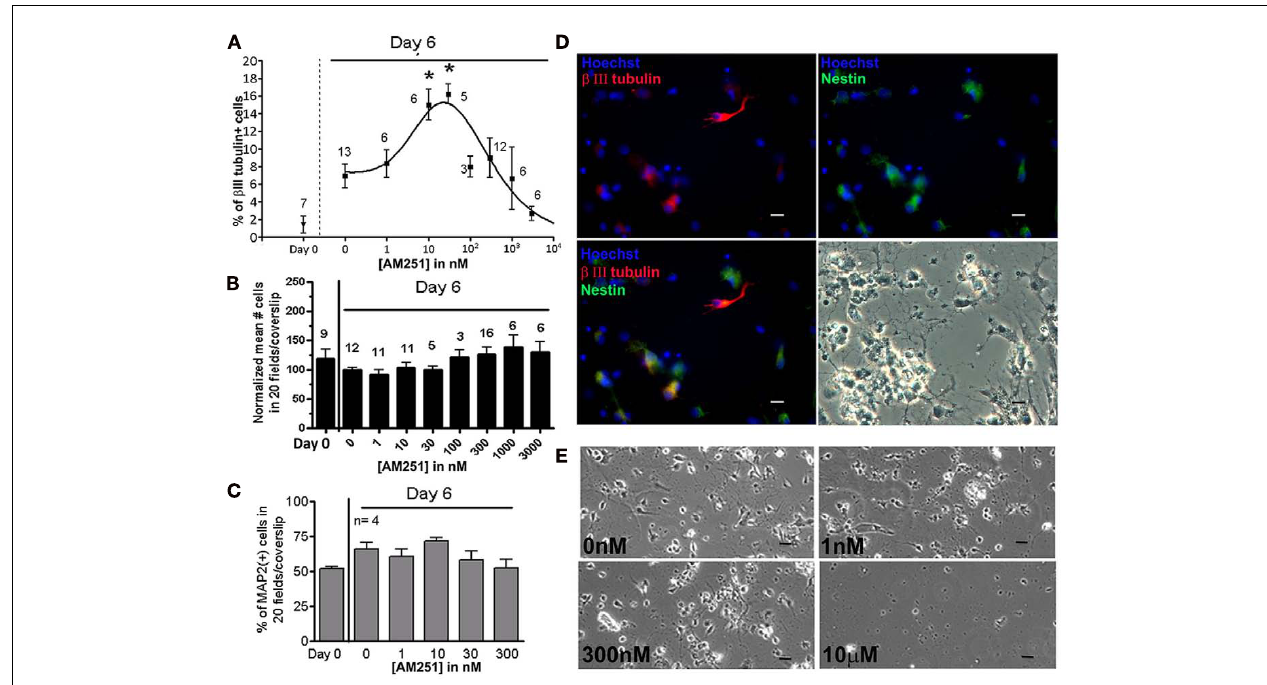
FIGURE 3 | Biphasic concentration–response ofAM251 for inducing neuronal differentiation without affecting the total number of cells. (A) In mixed cultures, cells were treated with increasing concentrations of AM251. Cells were fed every other day by replacing 75% of the culture medium. β III tubulin( + ) cells were quantified and expressed as a percentage of the total number of cells counted.Twenty to forty fields were analyzed per coverslip ( n ) = # coverslips from four separate experiments; mean ± SEM). Concentration–response curve was generated from four separate experiments. * p < 0.05 Between the group and the untreated group at Day 6. Using the bell-shaped curve function in Graph Pad Prism 5, the following equation was used: y = Max + [( α − Max)/ (1 + 10 ∧ (( ε up − x )*nH 1 ))] + [( ω − Max)/(1 + 10 ∧ (( x − ε Dn )*nH 2 ))], where Max represents the plateau level in the middle of the curve; α and ω represent the plateaus on the left and right sides of the curve, respectively; ε up is the logEC 50 and ε Dn is the logIC 50, the concentrations that give half maximal stimulatory and inhibitory effects, respectively; and nH 1 and nH 2 are the Hill slopes.This curve approximates an EC 50 of 7.5nM, and an IC 50 of